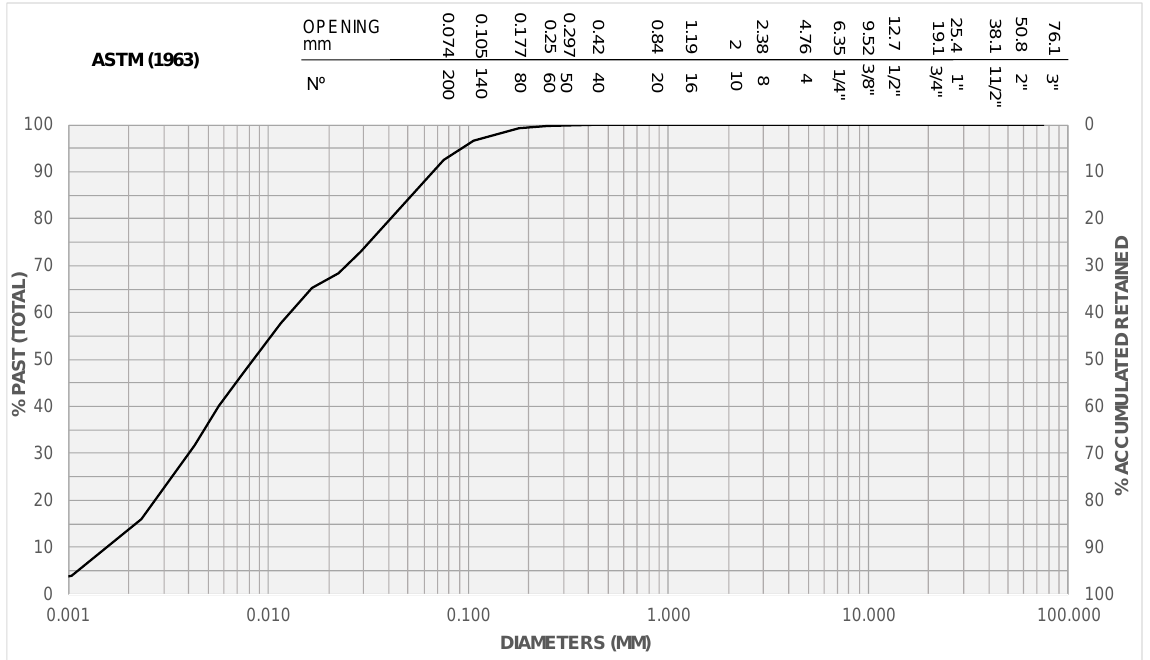
Figure 1. Mine tailing used in this study.